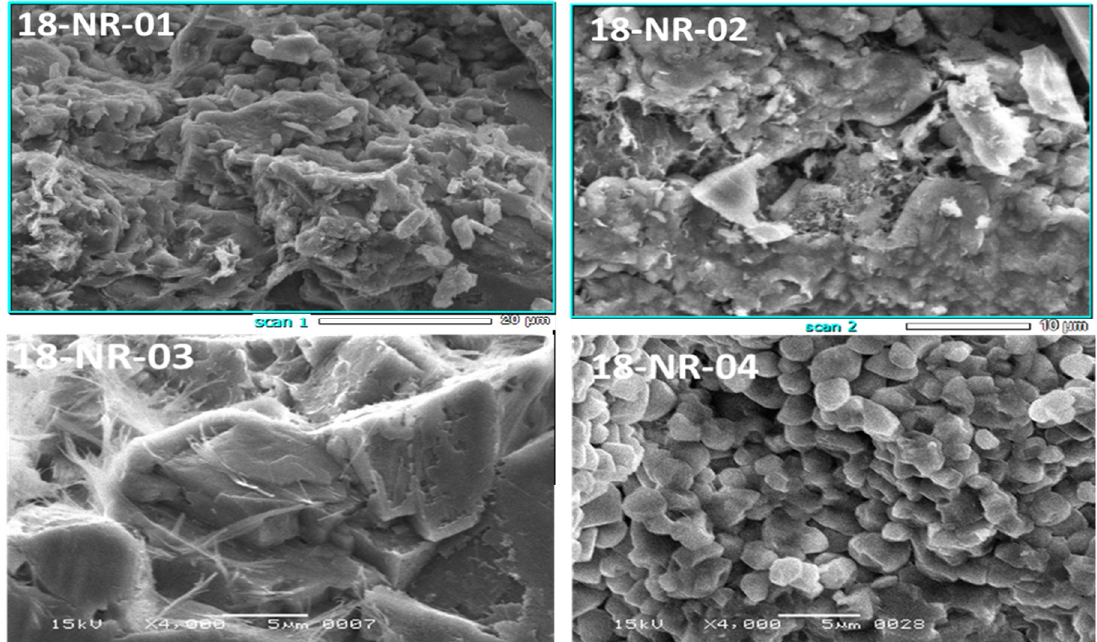
Fig. 3: SEM Photomicrograph of Nari Formations, The Results show the dominant minerals as (Ca), (C), (Si), (Fe), (Mg), (Al) and (K)